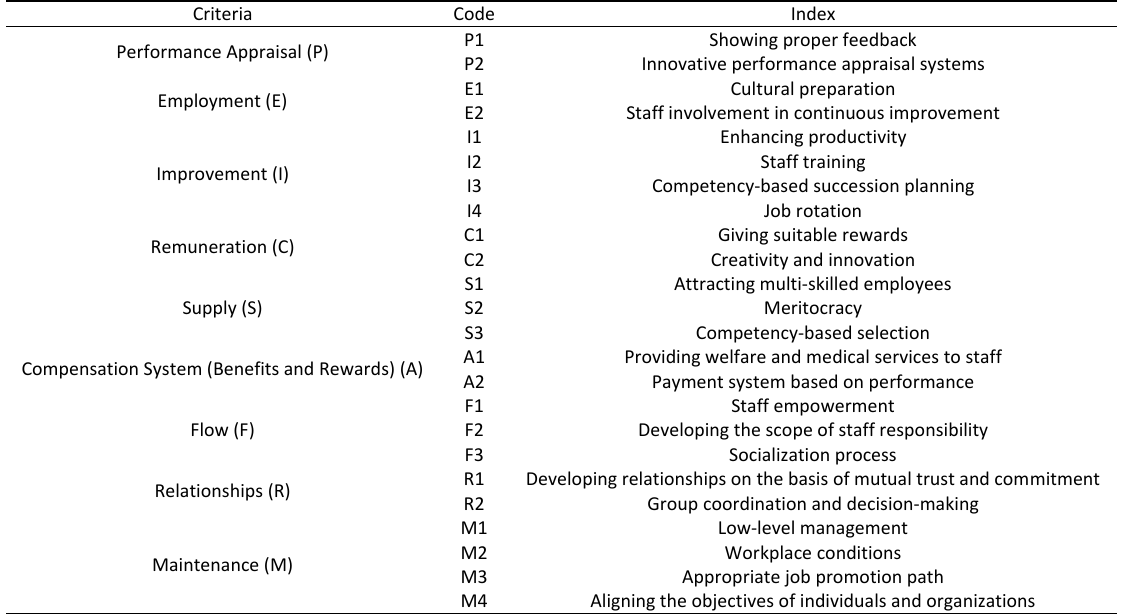
Table 1: The domestic model of LHRM